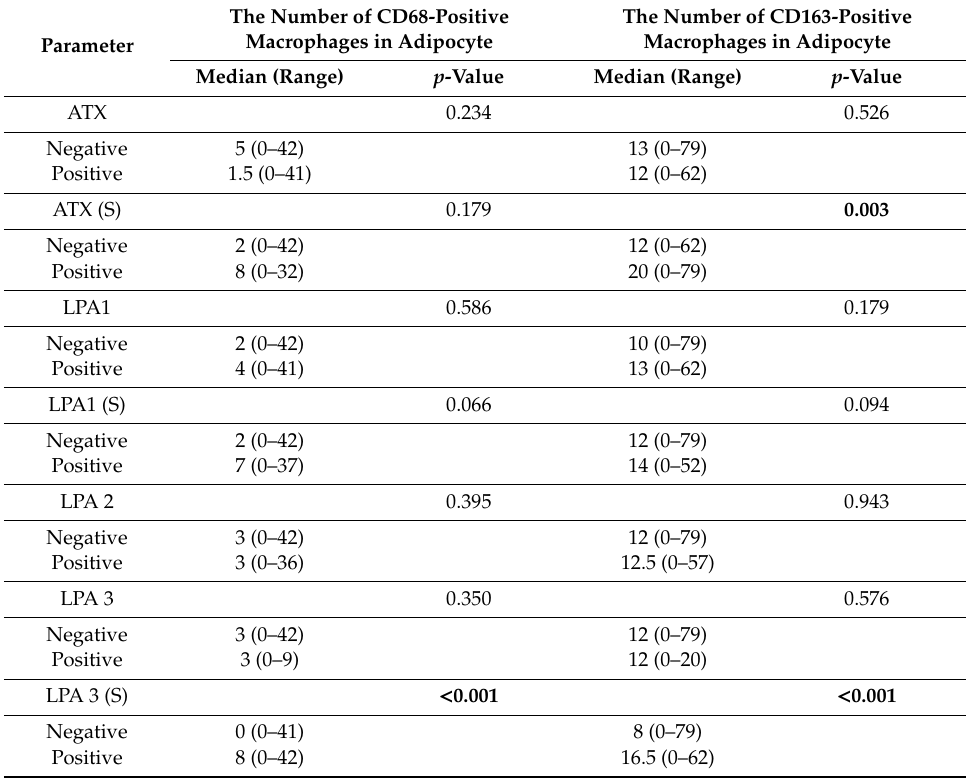
Table 6. The number of CD68- and CD163-positive macrophages in adipocytes according to the expression of ATX-LPA signaling-related